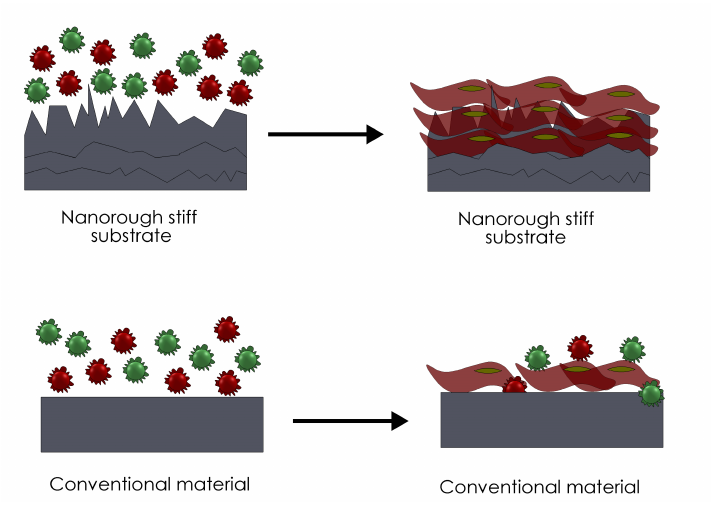
Figure 2. Researchers have exploited nanomaterial characteristics for biomaterial applications by increasing its surface-area ratio. This augmentation in surface-area ratio can enhance protein absorption, thus increasing the possibility of cell recruitment and